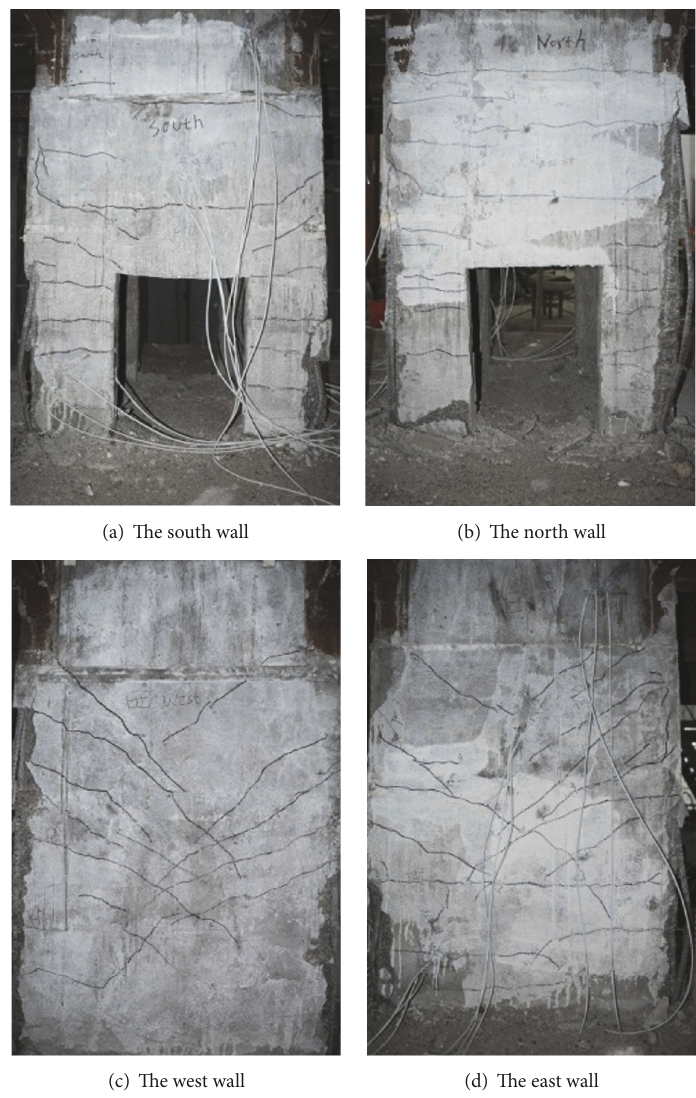
Figure 12: Cracks on core tube at the first